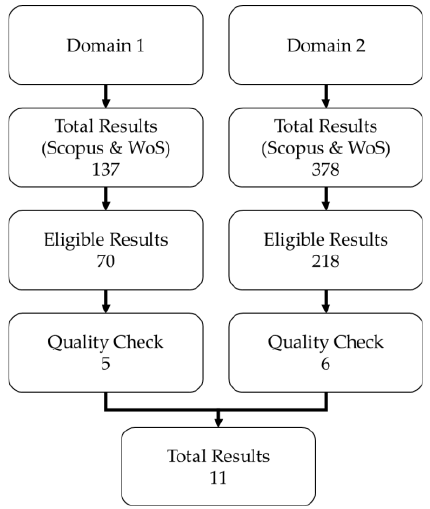
Figure 10. State-of-the-Art review based on PRISMA